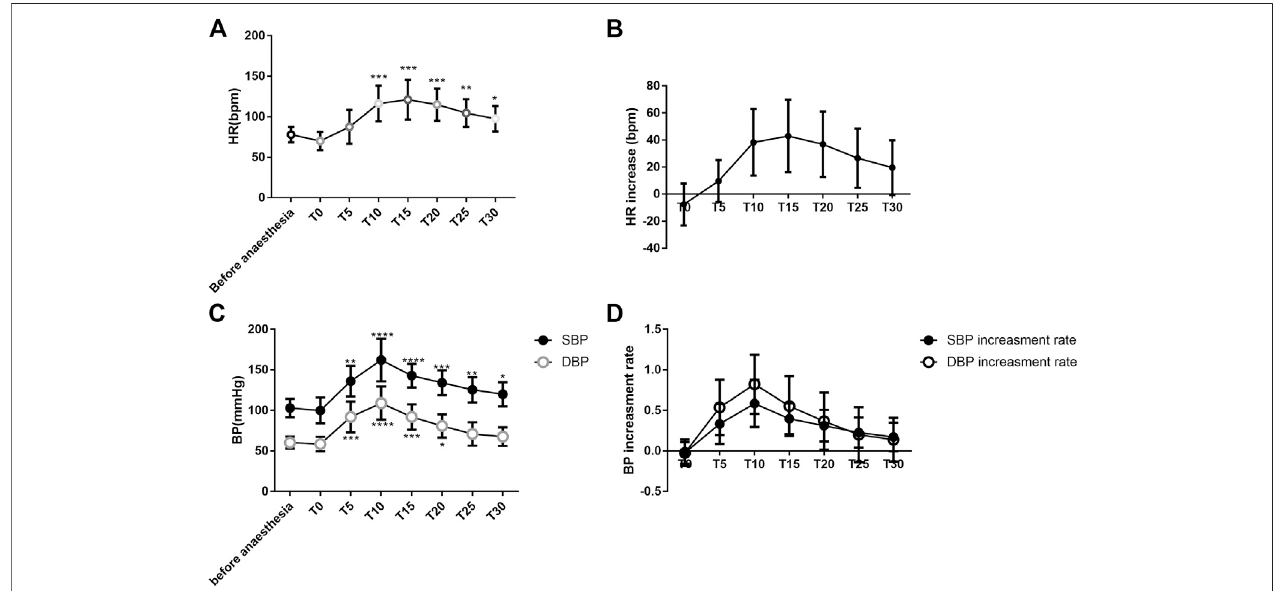
FIGURE 1 | Changes in the heart rate and blood pressure of patients (A) . Changes in HR associated with anesthesia and intravenous atropine treatment; (B) . Increase in HR associated with anesthesia and intravenous atropine treatment; (C) . Changes in blood pressure associated with anesthesia and intravenous atropine treatment; (D) . Increase in blood pressure associated with anesthesia and intravenous atropine treatment. Error bars represent the mean ± SD; the comparison was performedusingone-wayANOVA.SBP,systolicbloodpressure;DBP,diastolicbloodpressure;MAP,meanarterialpressure;HR,heartrate.T0,immediatelyafter anesthesiainduction;T5,T10,T15,T20,T25,andT30,representing fi ve,ten,15,20,25,and30 minafterintravenousatropinetreatment,respectively.N (cid:1) 13.* p < 0.05, ** p < 0.01, and **** p < 0.0001 compared with the before anesthesia group.